Question: Which visualization type does this figure use?
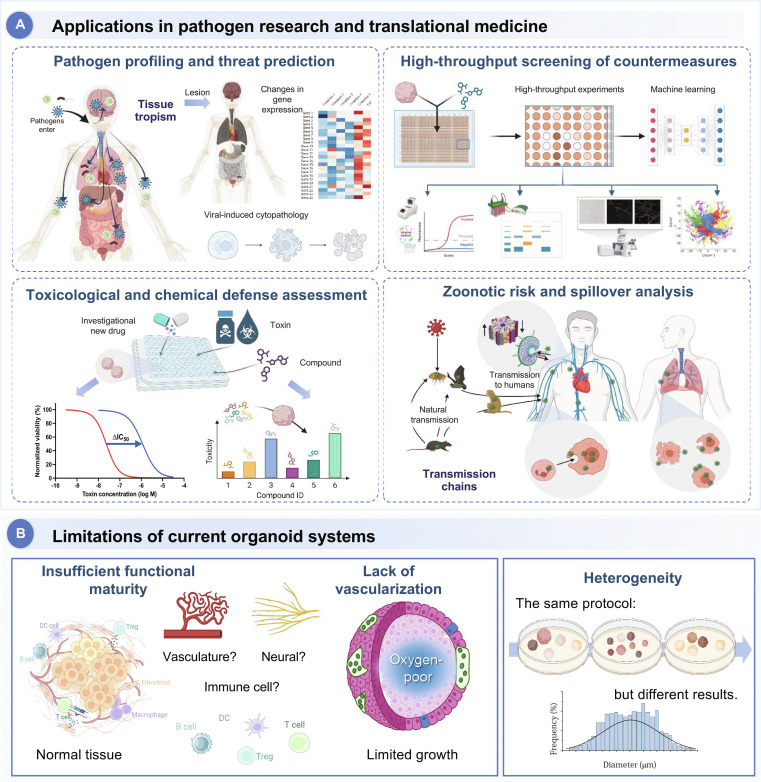
Answer: line